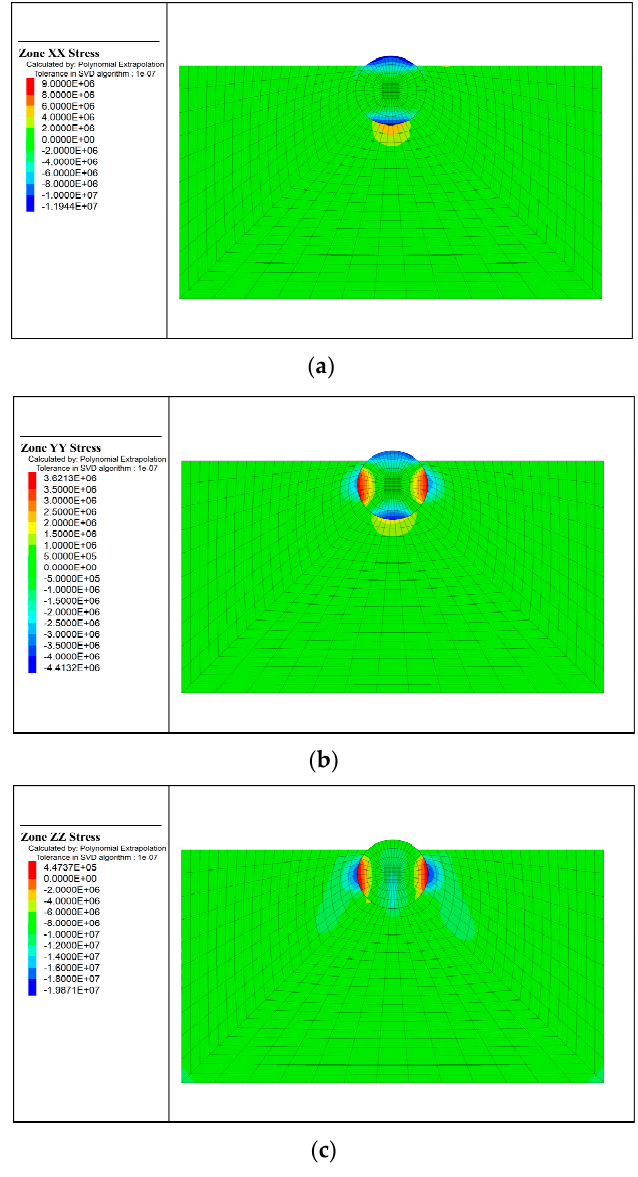
Figure 12. Initial stress field: ( a ) x-directional stress in the initial equilibrium; ( b ) y-directional stress in the initial equilibrium; and ( c ) z-directional stress in the initial equilibrium.